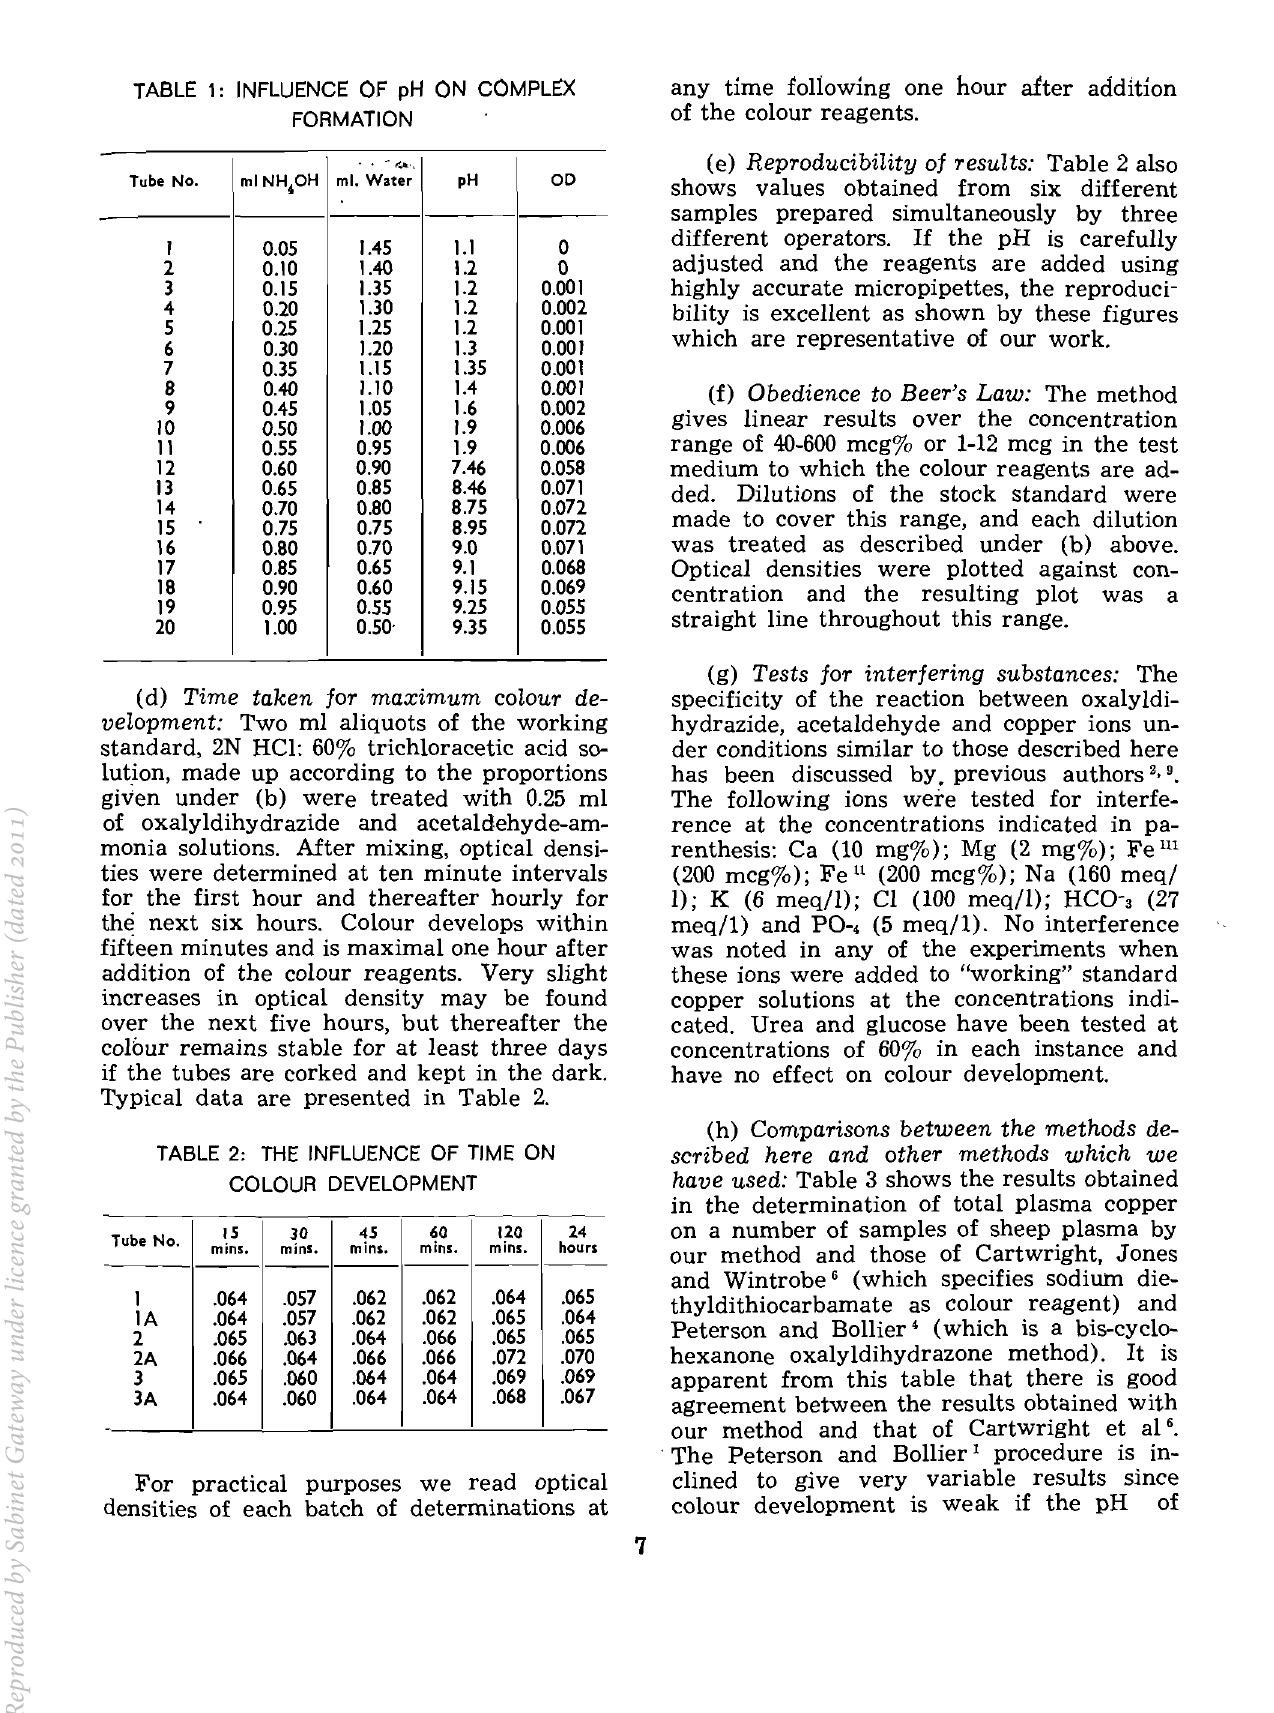
TABLE 1: INFLUENCE OF pH ON COMPLEX FORMATION